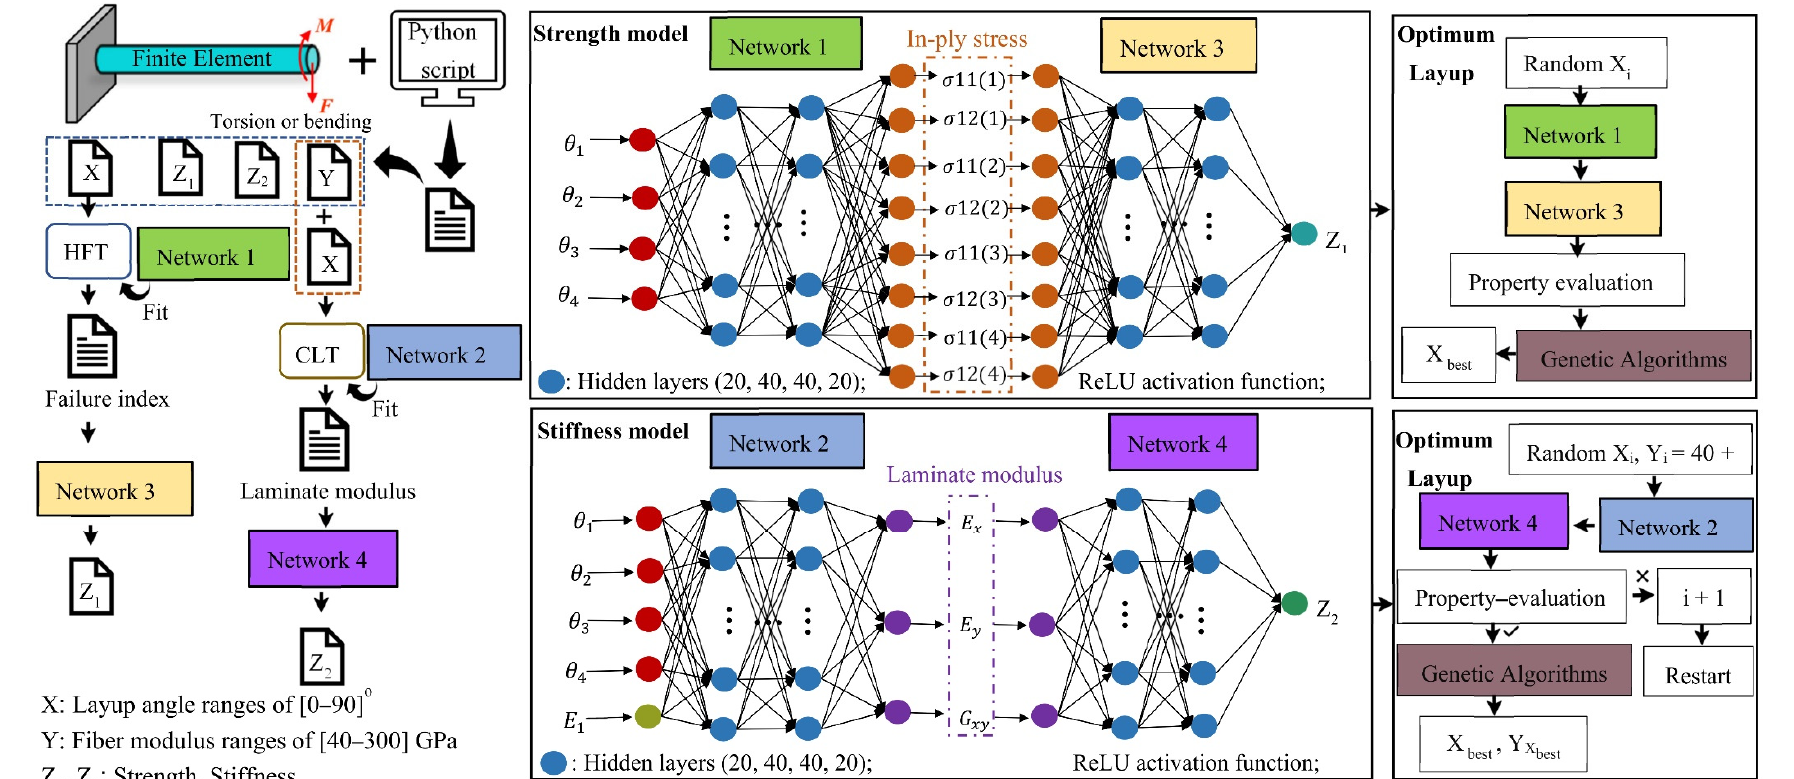
Figure 2. The theory-guided machine learning model process.